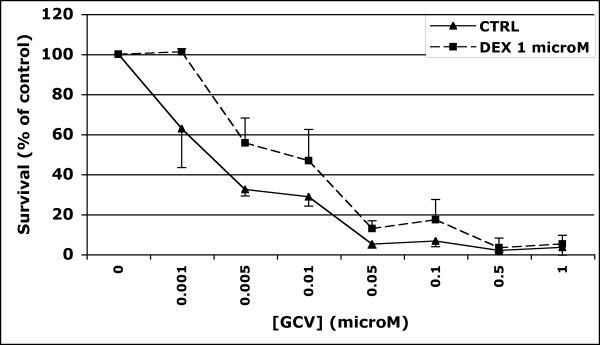
Sensitivity of C6-TK cells to ganciclovir. The sensitivity of C6-TK cells is shown in control conditions (▲) and in response to treatment with 1 μM dexamethasone (■). Results are expressed as the percentage of living cells in treated conditions at various concentrations of ganciclovir with respect to ganciclovir-free cultures, and are shown as the mean of 3 independent experiments.